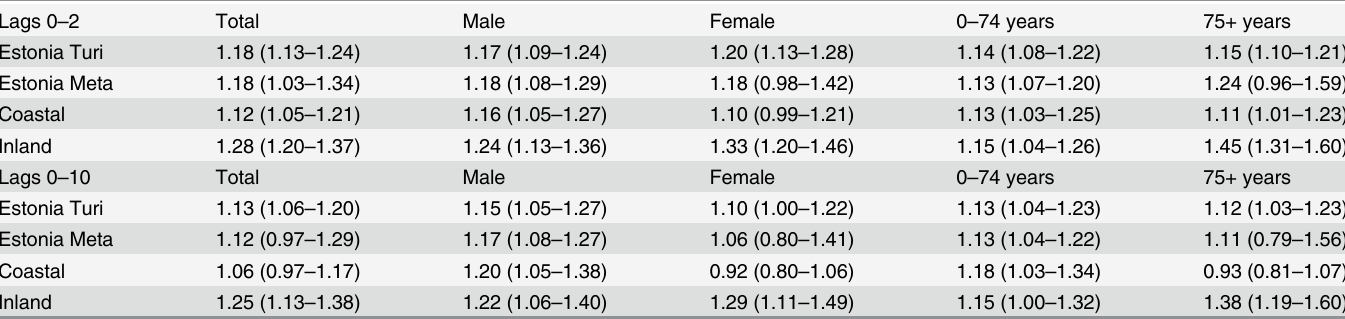
Table 3. Cumulative Relative Risks over lags 0 – 2 and lags 0 – 10 with 95% Confidence Intervals for the 75 th vs. 99 th percentiles per region.